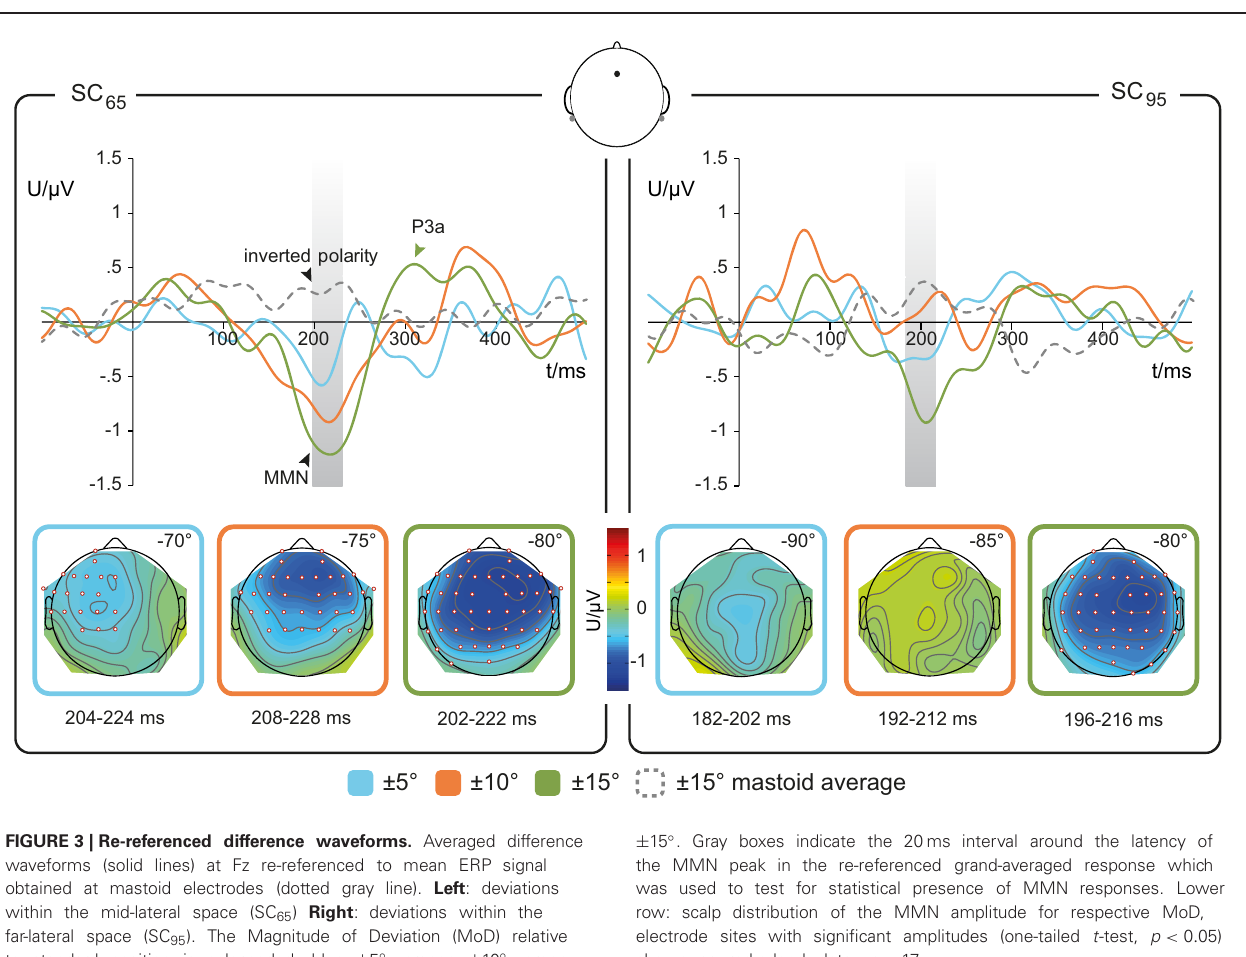
± 15 ◦ . Gray boxes indicate the 20ms interval around the latency of the MMN peak in the re-referenced grand-averaged response which was used to test for statistical presence of MMN responses. Lower row: scalp distribution of the MMN amplitude for respective MoD, electrode sites with significant amplitudes (one-tailed t -test, p < 0 . 05) shown as red-edged dots; n = 17.